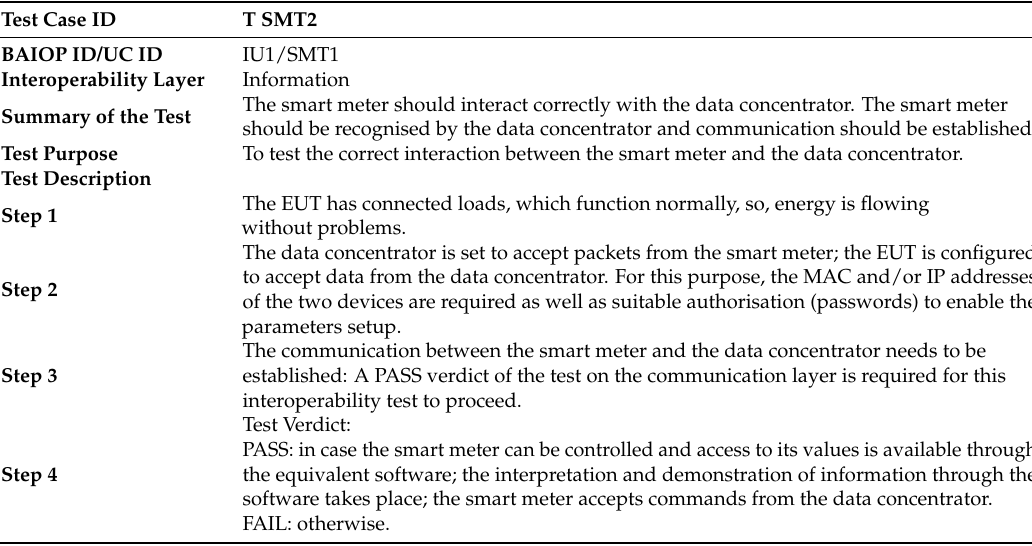
Table 3. BAIOP for the information layer, based on